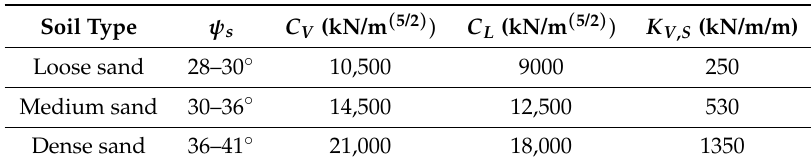
Table 1. Friction angles and stiffness values for pipe-soil interaction in sand. Adapted from Reference